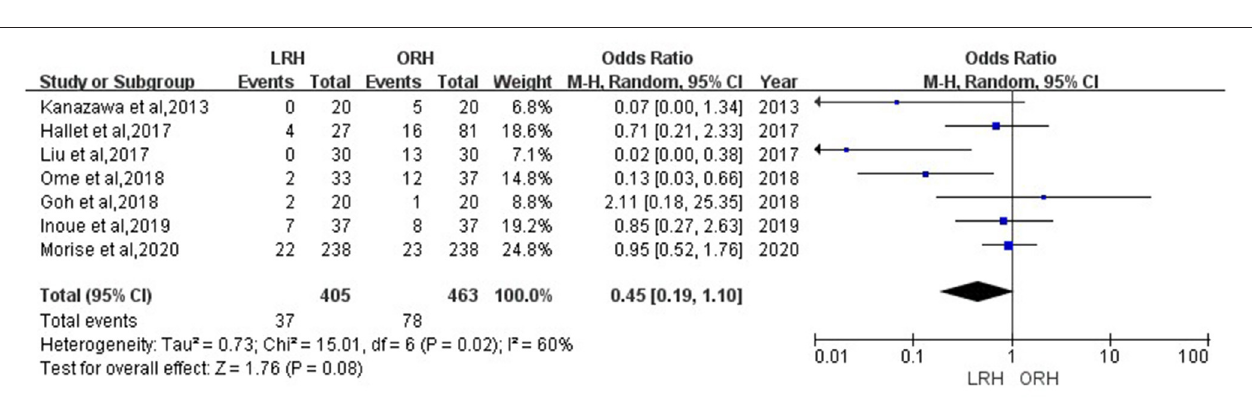
FIGURE 10 | Forest plots comparing blood transfusion rate between LRH group and ORH group.